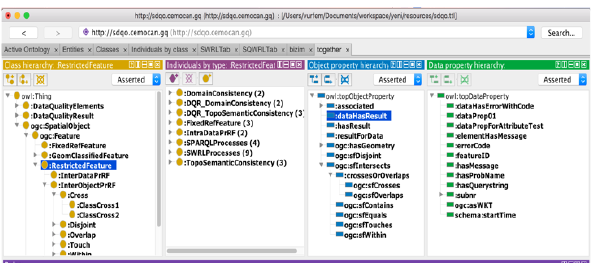
Figure 7. A path of subclass relations in a